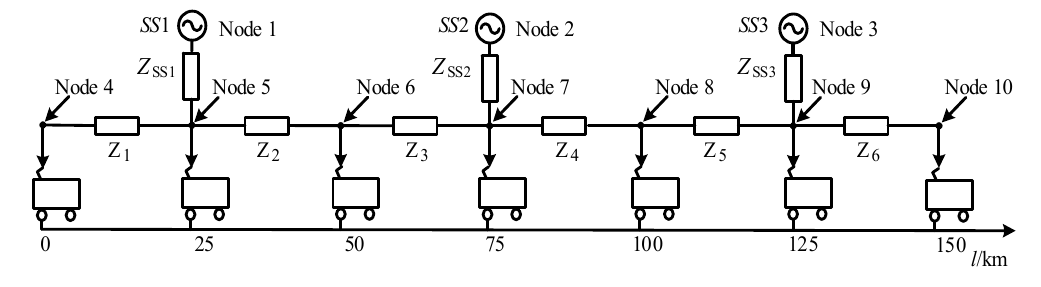
Figure 9. The equivalent model of ACTPSS.